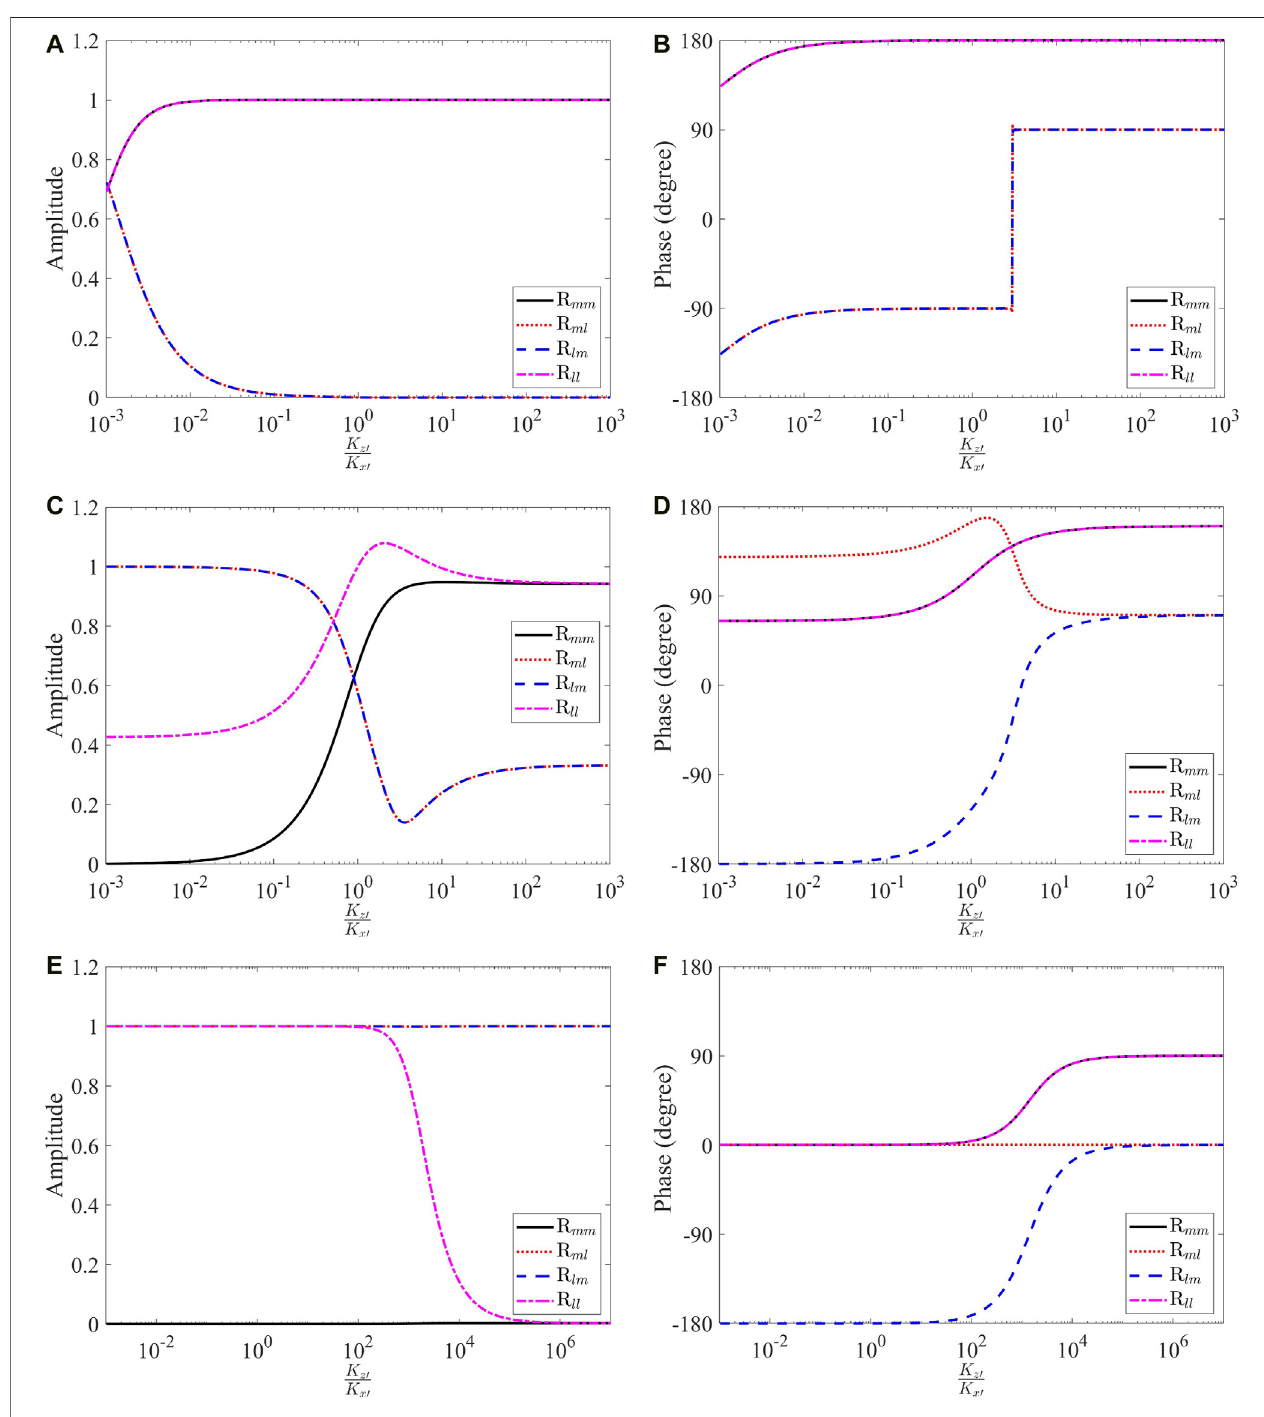
FIGURE 5 | The amplitude and phase of re fl ection matrix elements under different wave numbers k at C r (cid:2) C 12 / C 11 (cid:2) 0. (A,B) Amplitude and phase at k (cid:2) 0.001, (C,D) Amplitude and phase at k (cid:2) 1, (E,F) Amplitude and phase at k (cid:2) 1,000.